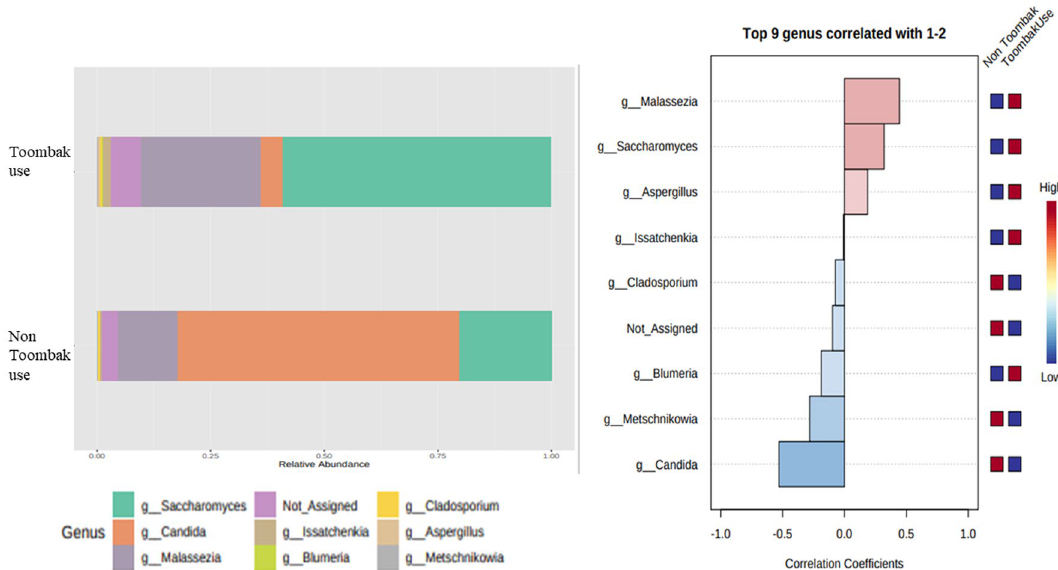
Figure 6. Fungal entities in pooled saliva amongst Sudanese users and non-users of Toombak and correlation differentiators of fungal inhabitance in the oral cavity between Toombak users and non-users. Bar graph abundance (right) highlights marked loss of Candida presence in the oral cavity of Toombak users and an increase in Saccharomyces and Aspergillus . Unassigned species were also abundant amongst Toombak users. Correlation plotting (left) configures abundances in Malassezia, Saccharomyces and Aspergillus that were correlated positively with Toombak use while Candida was the genus most correlated with non-users of